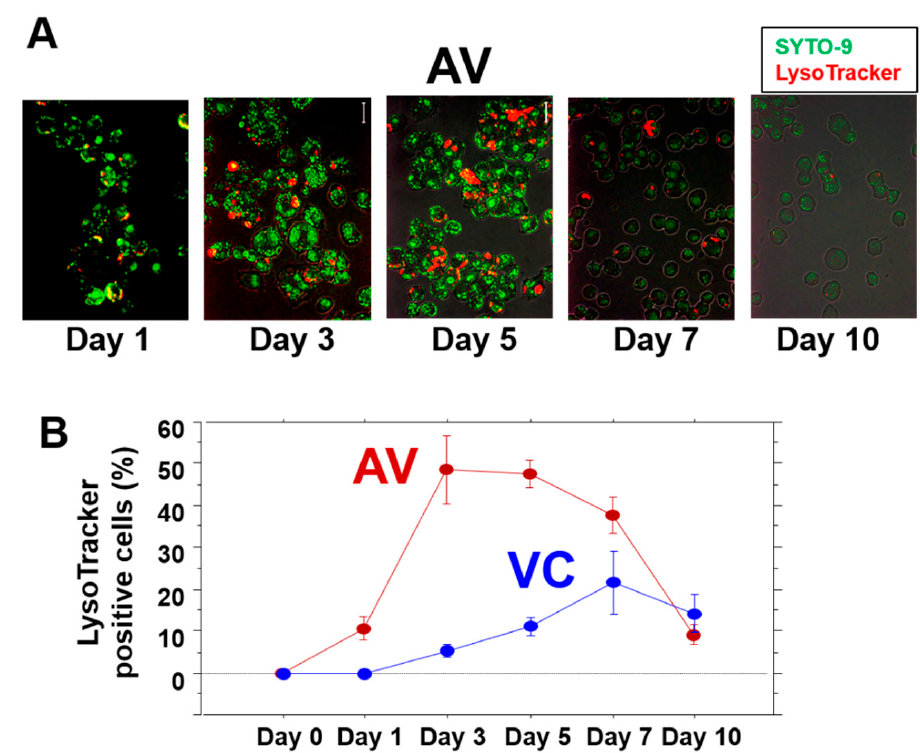
Figure 4. LysoTracker-positive lysosome in J774A after ingesting OJ-1. ( A ) Representative images of intracellular OJ-1 stained with SYTO-9 (green) and lysosome expression stained with LysoTracker in J774A cells (red) during 10 days of the study. ( B ) The time course of the cells with LysoTracker-positive lysosome per total number of cells in the VC and AV groups. Values are the mean of triplicated data ± S.D.